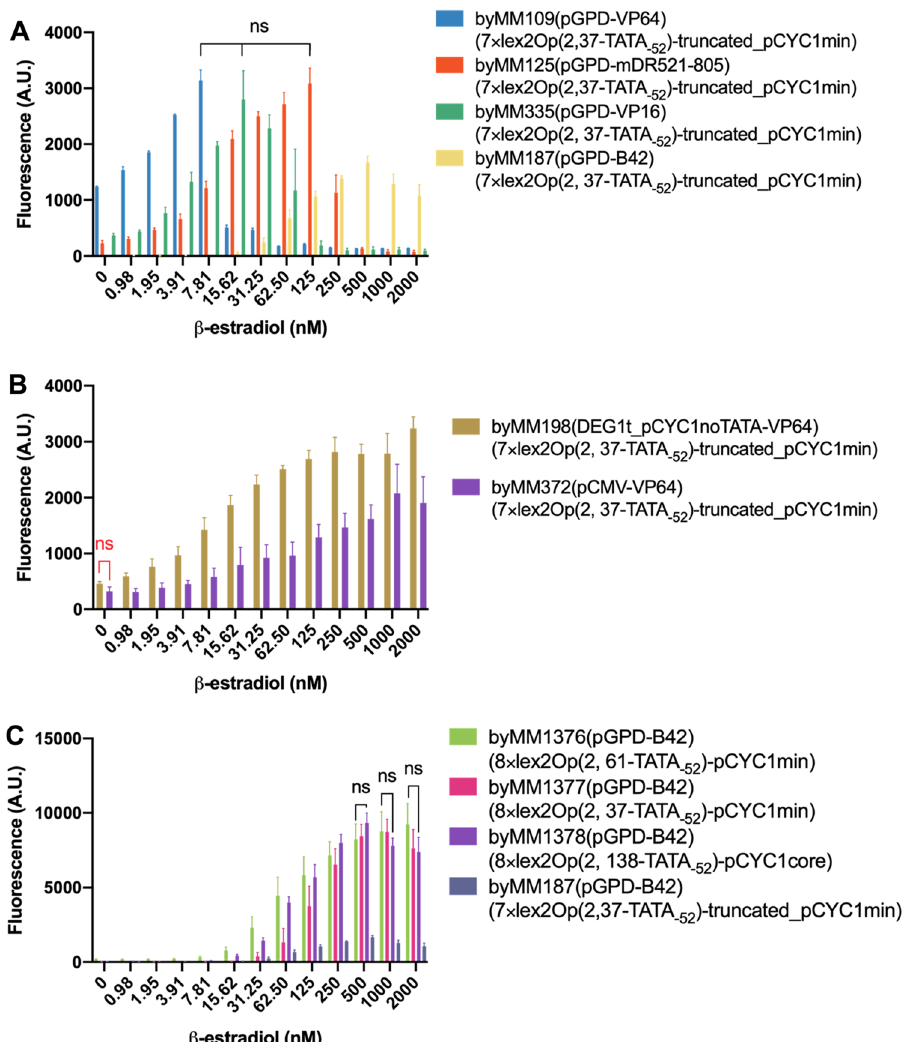
Figure 3. Response of biosensors 1–3 to increasing concentrations of β-estradiol. ( A ) Biosensors 1. The receptor TU employs the strong pGPD, whereas the AD is variable. The promoter in the reporter TU is characterized by seven copies of lex2Op—spaced by only 2 nt—that lie 37 nt upstream of the very weak truncated_pCYC1min. Despite the high number of lex2Op and the presence of strong ADs in large amount, our synthetic promoter was poorly activated. The maximal fluorescence level of byMM1376-byMM1378 are statistically equivalent (ns: one-way ANOVA; p-value = 0.4843). ( B ) Biosensors 2. DEG1t_pCYC1noTATA and pCMV drove the expression of the chimeric activator carrying the strong VP64 AD. The two promoters caused a statistically identical basal fluorescence (ns: p-value = 0.076; two-tailed Welch’s t-test—in red in every figure). DEG1t_pCYC1noTATA had a greater detectability than pCMV (3.91 and 15.62 nM β-estradiol, respectively) and returned the highest fluorescence intensity. ( C ) Biosensors 3. The presence of the full pCYC1 5 ′ UTR enhanced the maximal fluorescence level with respect to biosensors 1 and 2 without any relevant increment in the basal fluorescence. The fluorescence values of the three versions of biosensor 3 at 500, 1000, and 2000 nM β-estradiol did not show any statistically significant difference (ns: one-way ANOVA; p-value = 0.3224, 0.4226, and 0.2130,